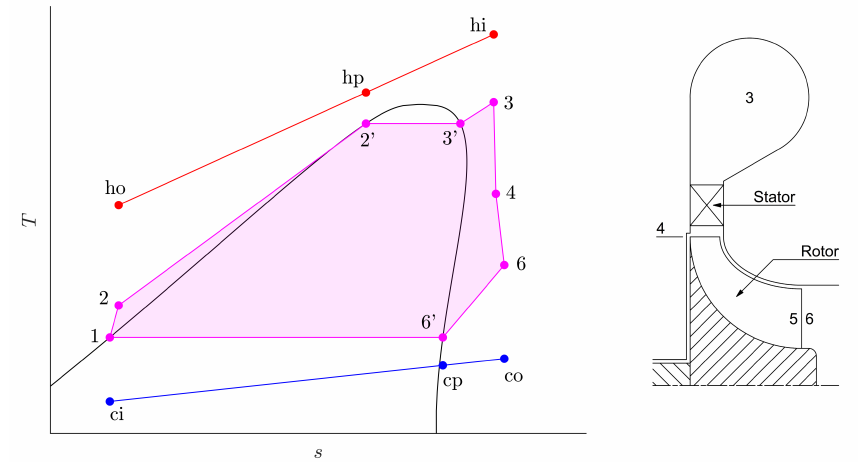
Figure 2. Notation used to describe the thermodynamic cycle ( left ) and a radial turbine ( right ). In the left figure the red and blue lines correspond to the heat source and heat sink temperature profiles respectively, and the magenta lines represent the thermodynamic